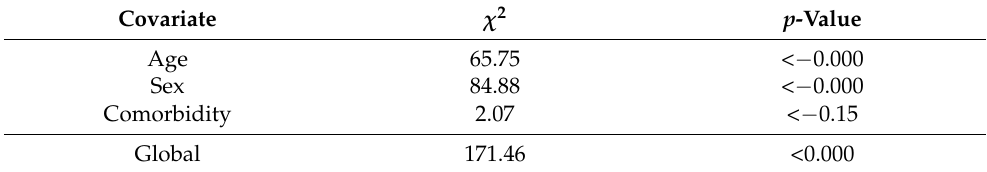
Table 19. Chi-square ( χ 2 ) test and p -value for Schoenfeld residual test at level of significance 1%. Covariate χ 2 p -Value Age 65.75 Sex 84.88 Comorbidity Global